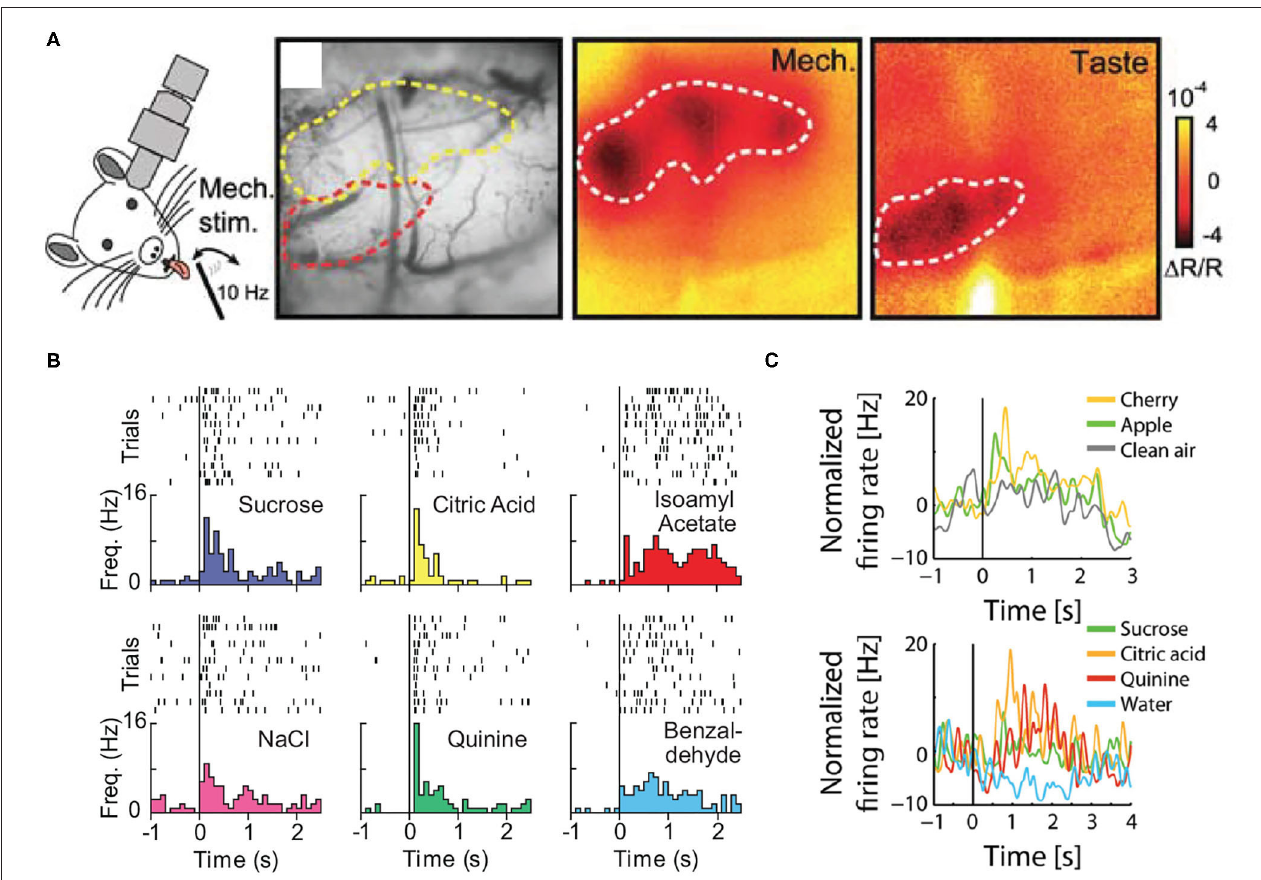
FIGURE 2 | (A) In vivo intrinsic optical imaging of the oral-somatosensory cortex and gustatory cortex; note that the cortical region responding to taste stimuli is located ventral to the area activated by the tactile stimulation of the tongue. (B) The single-unit activity of a neuron in the gustatory cortex in response to the intraoral delivery of individual taste stimuli (sucrose, NaCl, citric acid, and quinine) and individual odors dissolved in water (isoamyl acetate and benzaldehyde). (C) The normalized activity of a neuron in the posterior piriform cortex in response to orthonasally presented odors (apple, cherry, and clean air) and intraorally delivered taste stimuli (sucrose, citric acid, quinine, and water). Panels adapted from (A) Copyright (2007) Society for Neuroscience (Accolla et al., 2007), (B) (Samuelsen and Fontanini, 2017 ), and (C) (Maier et al.,